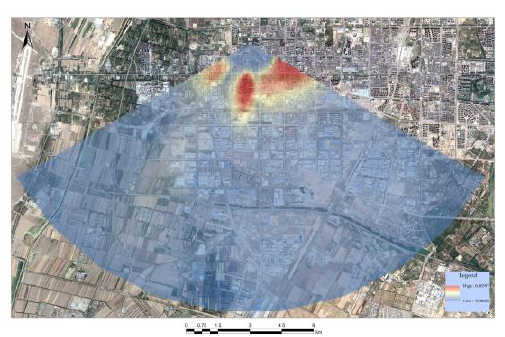
Figure 4. Horizontal scanning results of sunny days